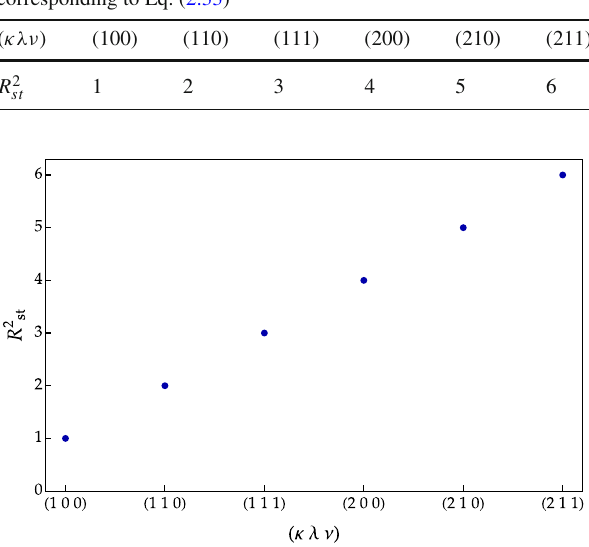
Fig. 2 Plot of the ratios R 2 st ≤ 6 corresponding to Eq. (2.33) and Table 3 for T